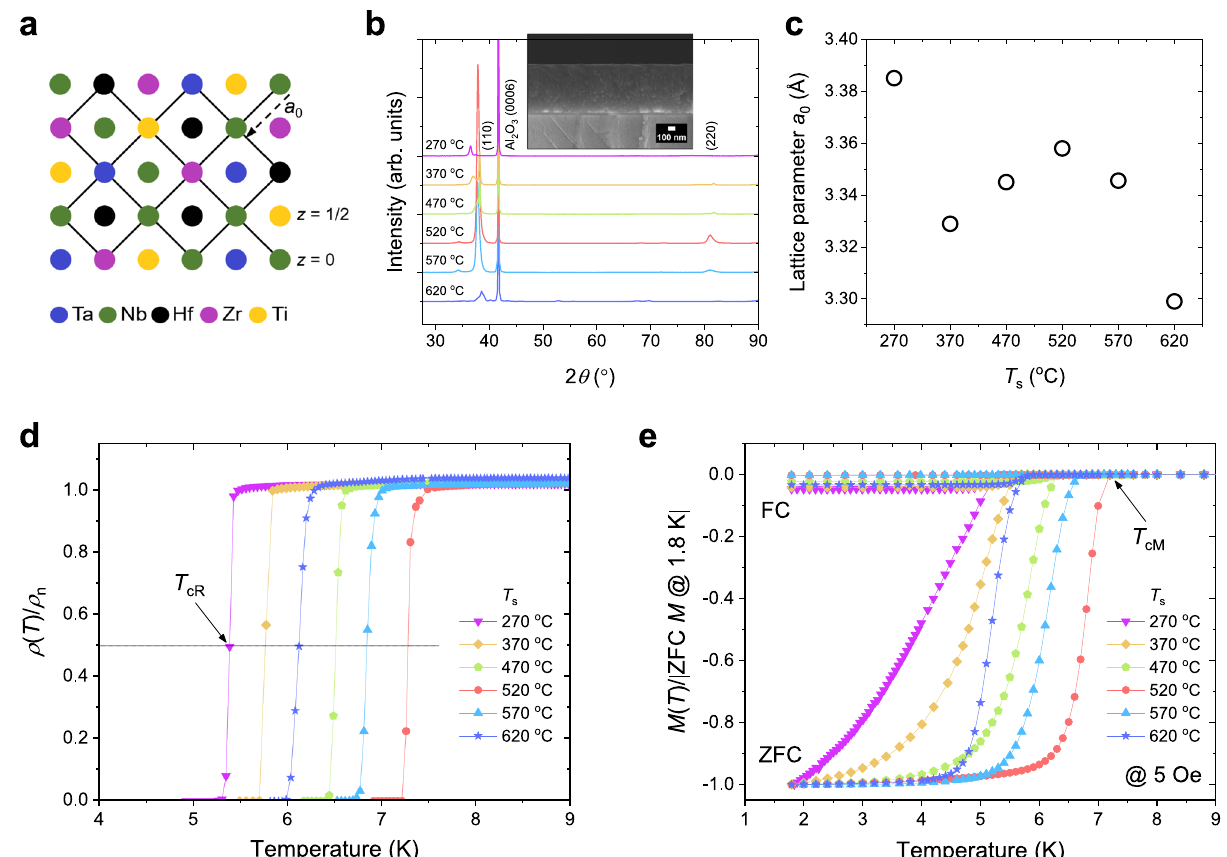
Fig. 1 Crystal structure and superconducting (SC) transition temperature of Ta – Nb – Hf – Zr – Ti HEA SC thin fi lms. a Schematic of the bcc lattice with randomly distributed atoms of the Ta 1/6 Nb 2/6 Hf 1/6 Zr 1/6 Ti 1/6 HEA superconductor. b XRD results for Ta – Nb – Hf – Zr – Ti HEA SC thin fi lms deposited on a c -cut Al T = 270, 370, 470, 520, 570, and 620 °C, indicating a (110) preferred orientation. The inset shows a cross-sectional SEM image 2 O 3 substrate at s for the fi lm fabricated at T s = 520°C. c The lattice parameter ( a 0 ) of HEA SC thin fi lms with respect to substrate temperature T s . d , e Temperature dependence of the electrical resistivity ( ρ ) and magnetization ( M ) for the Ta – Nb – Hf – Zr – Ti HEA SC thin fi lms, respectively. Here, ρ ( T ) and M ( T ) were normalized to the ρ at the T c onset ( ρ n ) and the absolute zero- fi eld-cooled (ZFC) M value at 1.8 K, respectively, for comparison. The fi eld-cooled (FC) and ZFC M ( T ) were measured at 5 Oe (applied perpendicularly to the fi lm